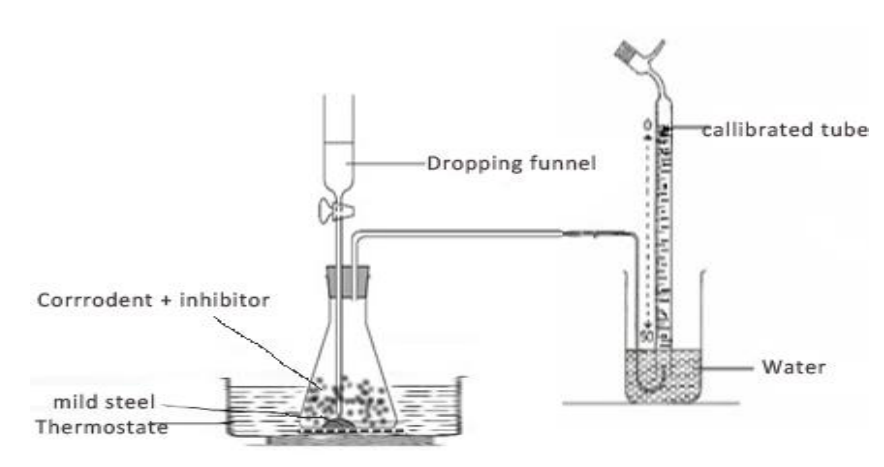
Figure 6: Schematic diagram of the set-up used for gasometric measurements [5]